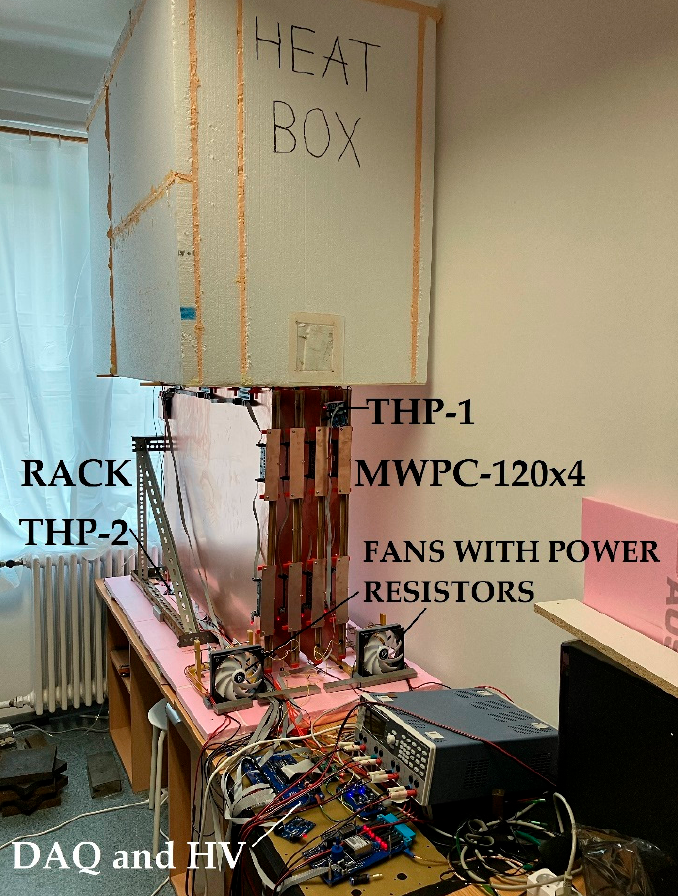
Figure 5. The measurement setup for the “Heat box”. Two 50 W power resistors are responsible for internal heating. The THP sensors were placed at two different locations inside to monitor the temperature field.